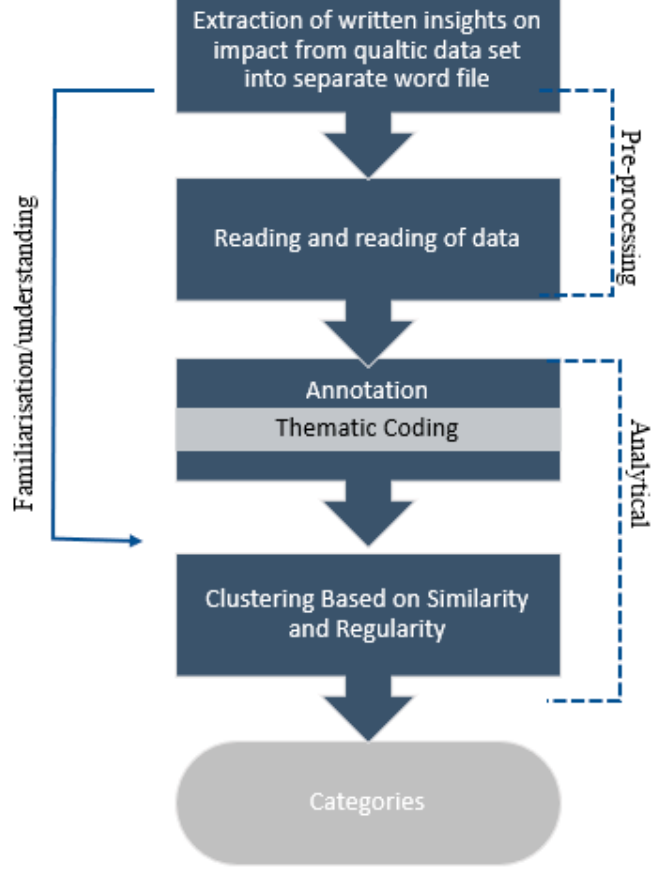
Figure 1. Analysis flowchart.